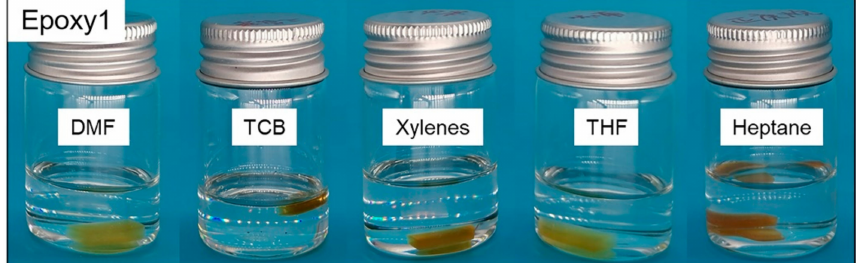
Figure 7. The appearance of Epoxy1 after being immersed in N,N-dimethylformamide (DMF), TCB, xylenes, tetrahydrofuran (THF), and heptane at ambient temperature for 96 h.